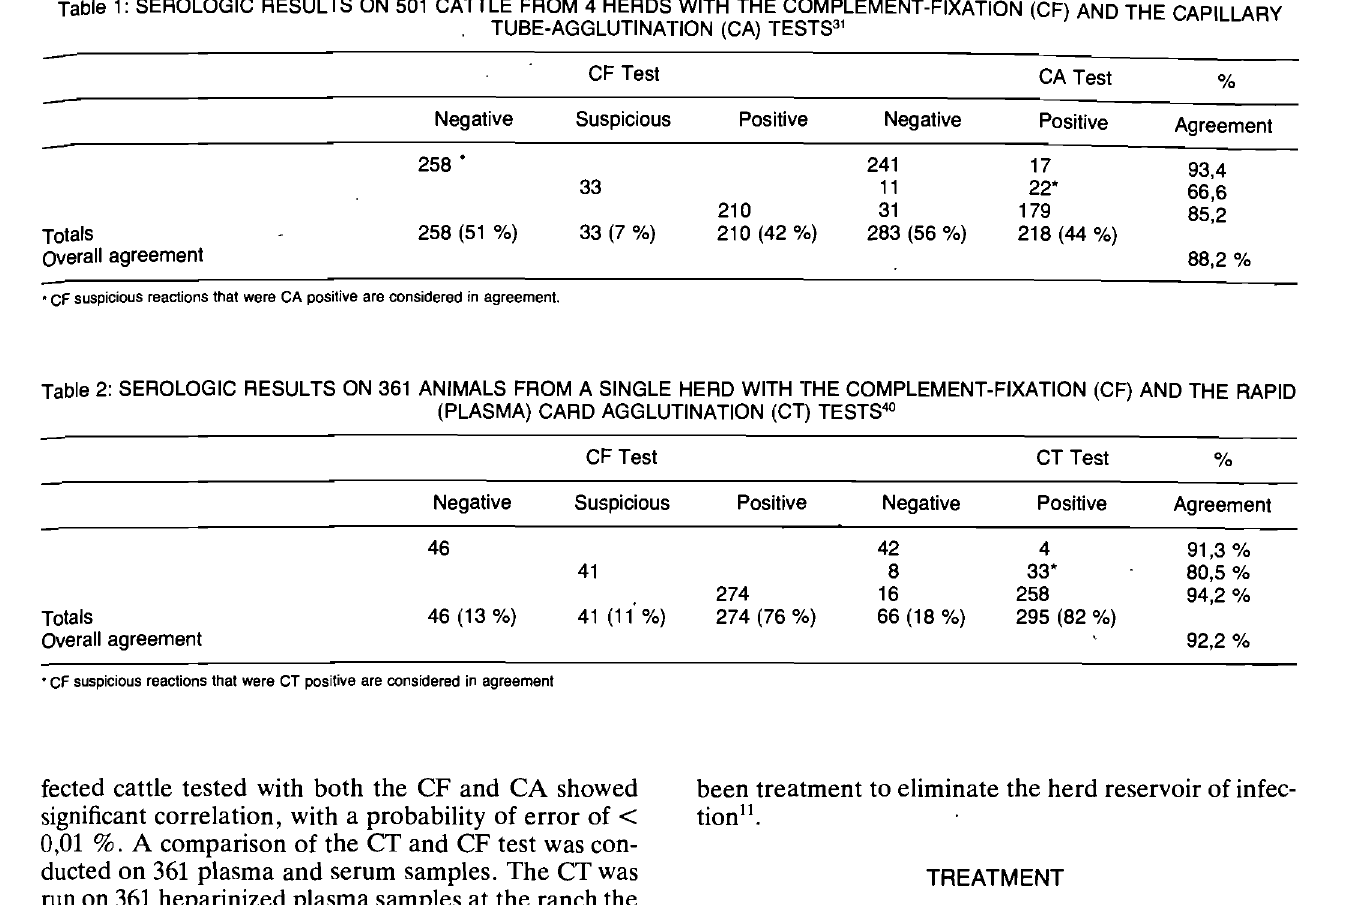
Table 1: SEROLOGIC RESULTS ON 501 CATTLE FROM 4 HERDS WITH THE COMPLEMENT-FIXATION (CF) AND THE , TUBE-AGGLUTINATION (CA) TESTS31